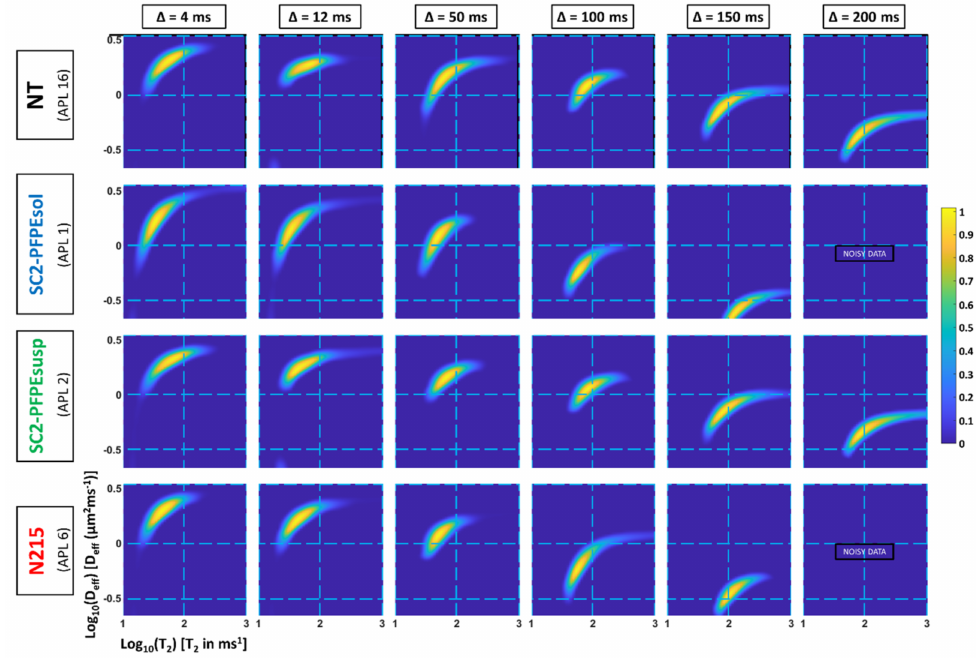
Figure 10. 2D maps at 15 mm depth of Log 10 ( D eff ) vs. Log 10 ( T 2 ) for coated and uncoated Lecce stone specimens. For each computed correlation map, the signal intensity was normalized to the maximum